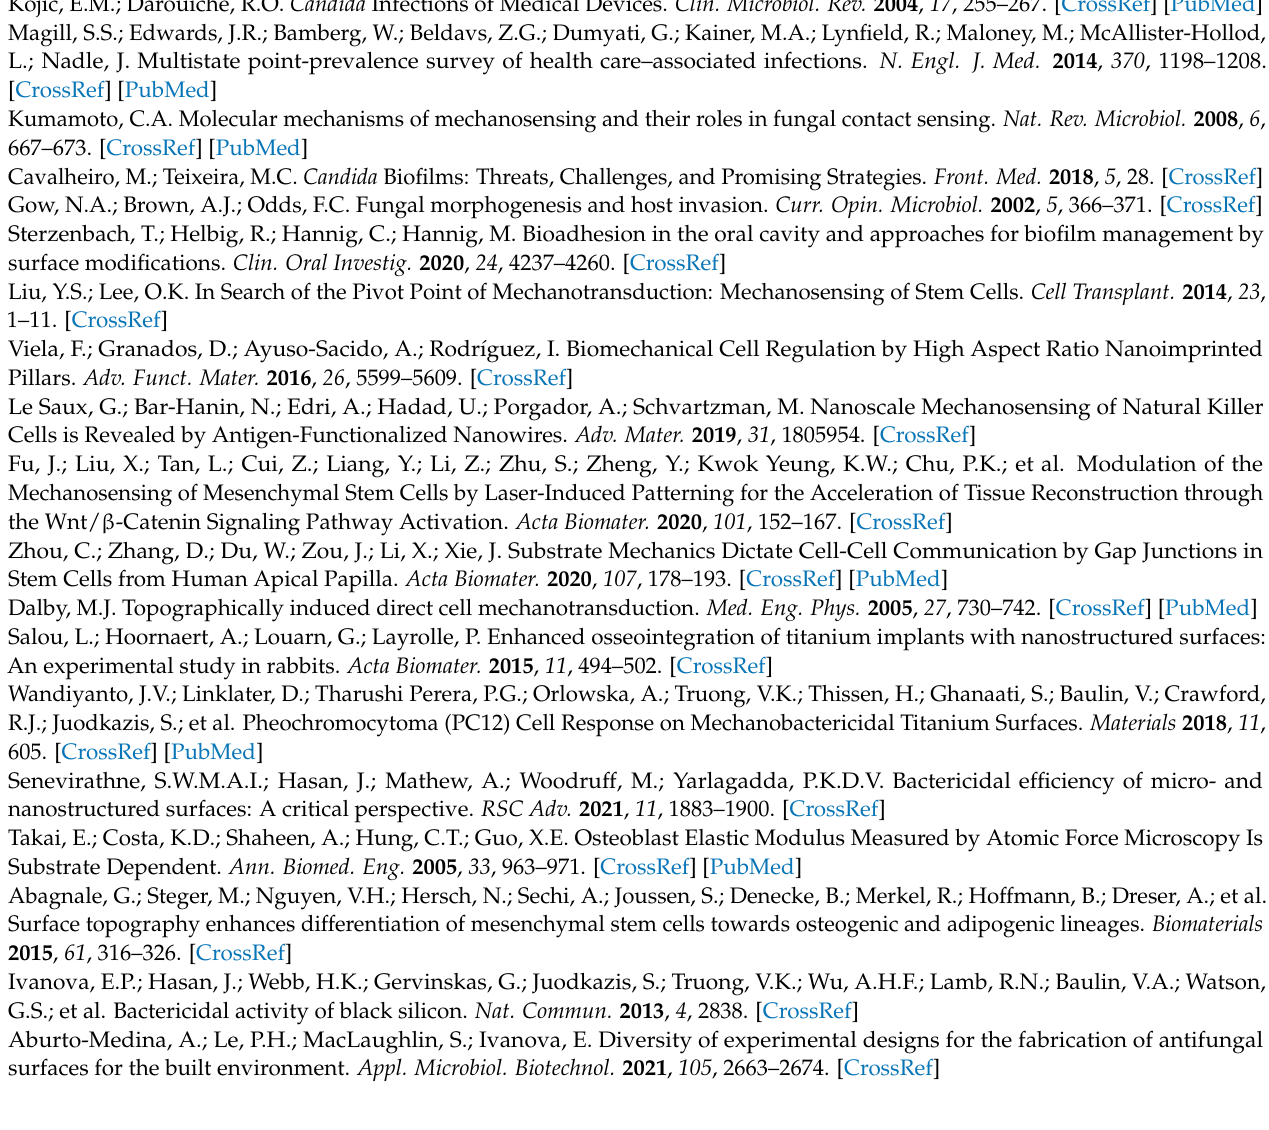
C. albicans budding; Figure S6: Representative force-distance curves in QI data of C. albicans cells attached on Ti, glass and pTi surfaces after a 3-day incubation